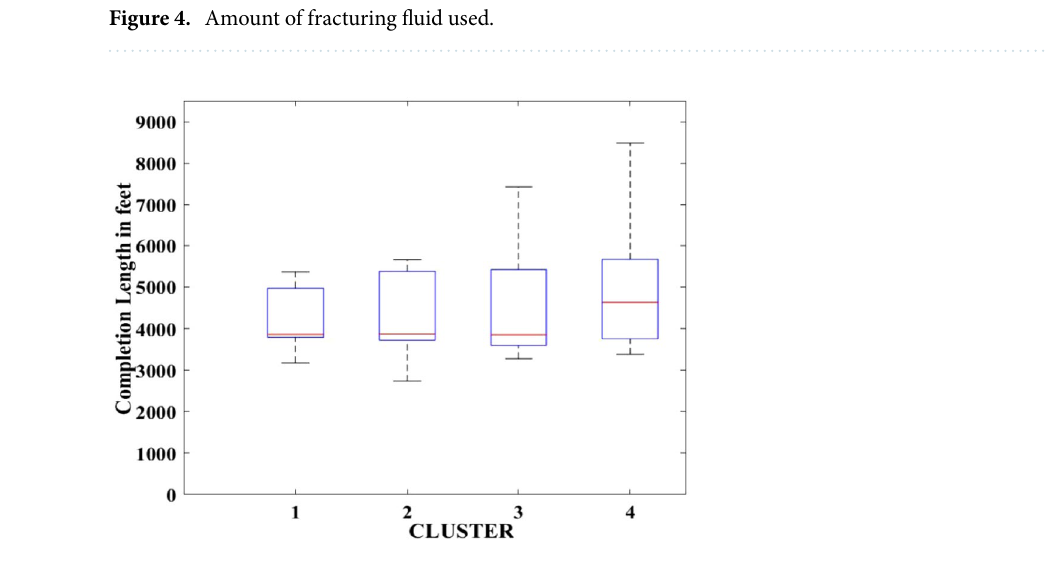
Figure 5. Completion